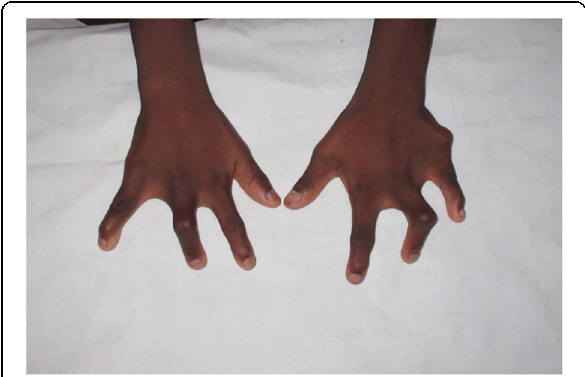
Fig. 4 Hand photo of patient II.3 showing similar deformity as proband